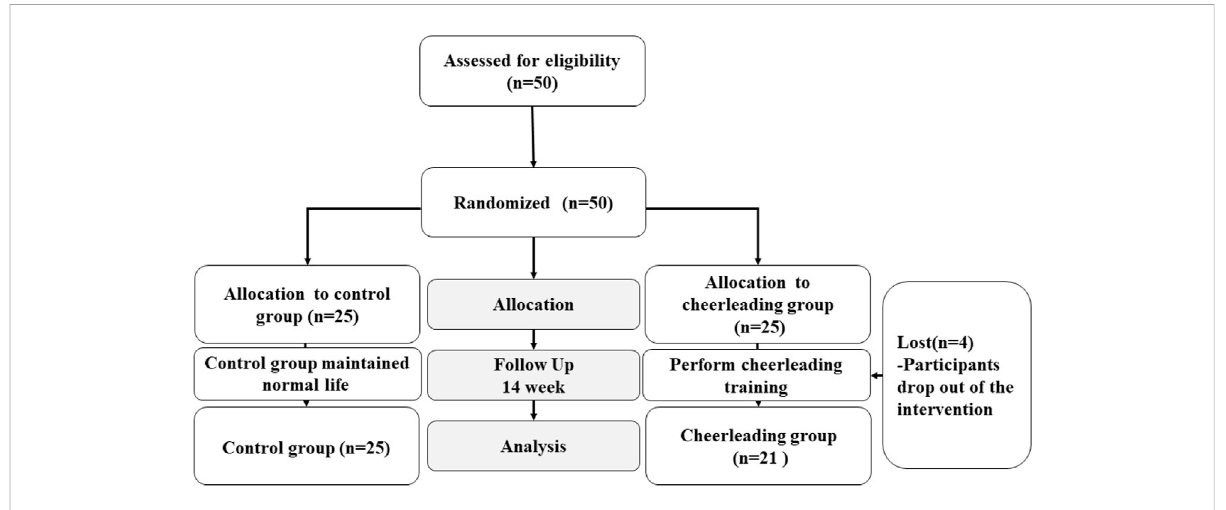
FIGURE 1 Participants ’ recruitment and intervention fl ow